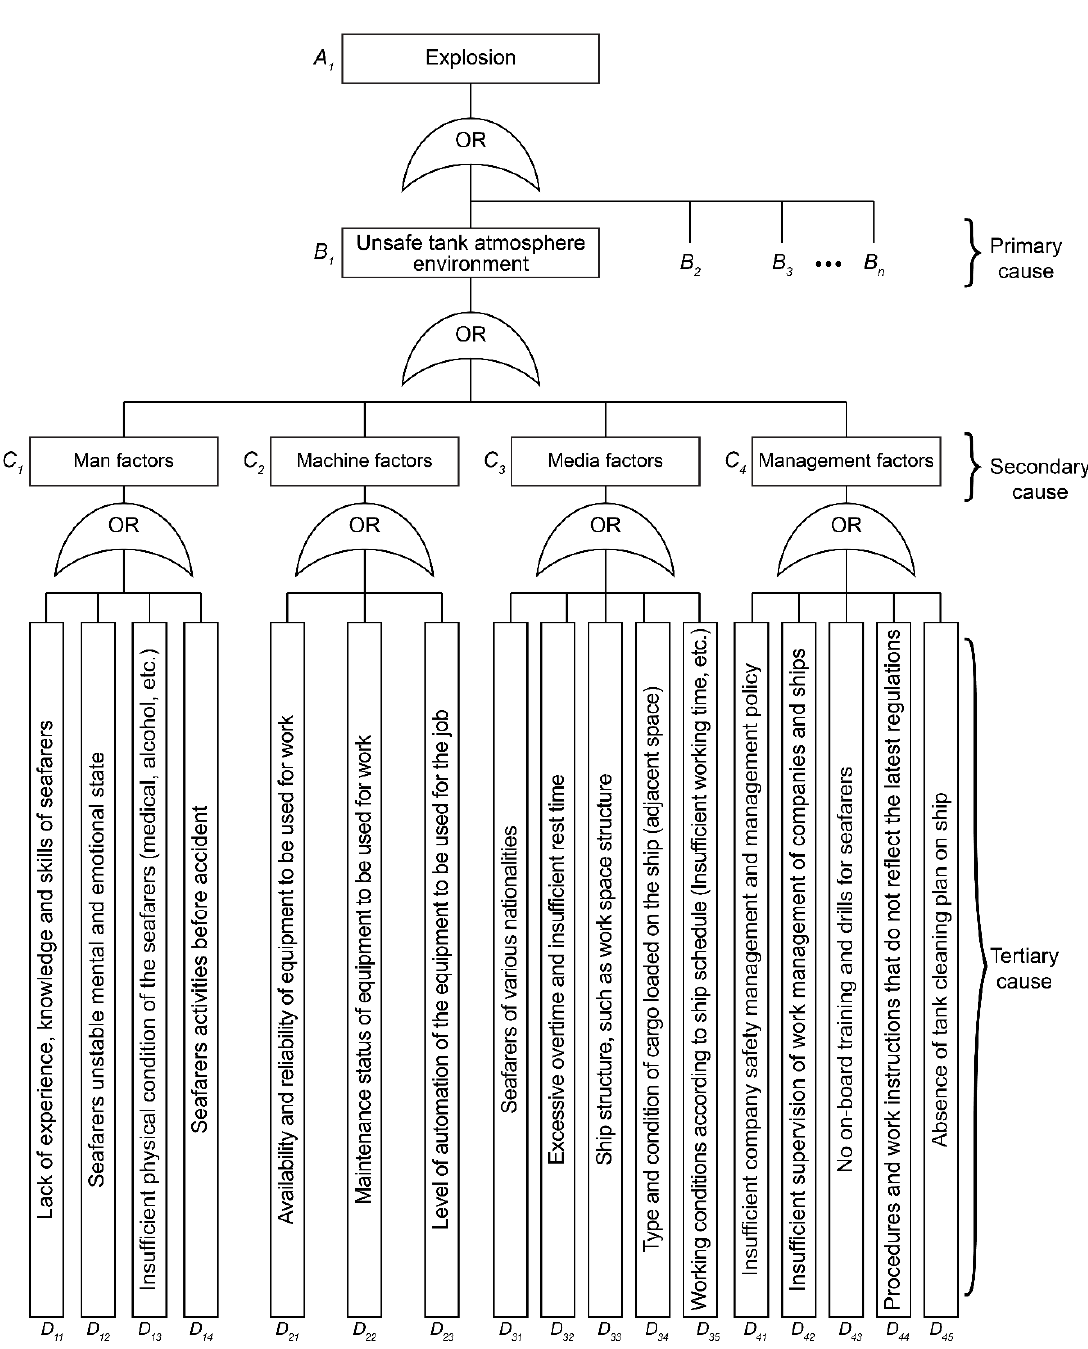
Figure 2. Fault tree diagram for analysis of explosion accidents caused by unsafe tank atmosphere environment.